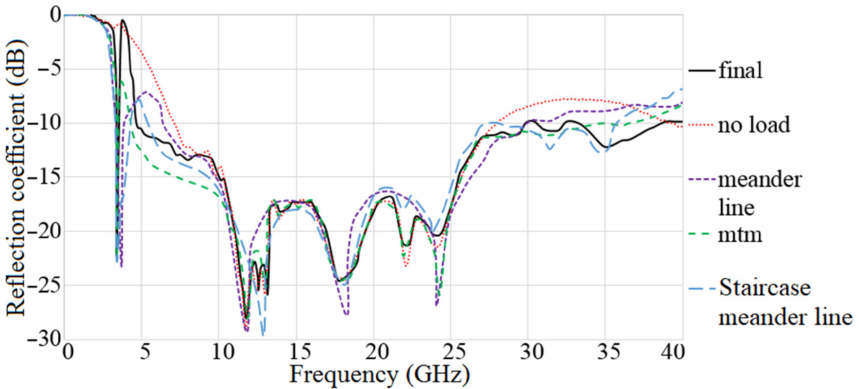
Figure 13. The S 11 results of MTM based MAVA for each stage.